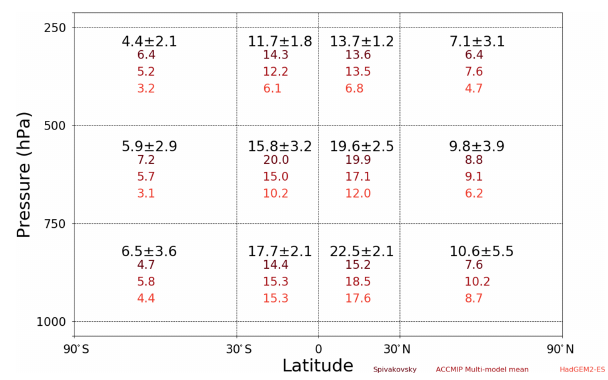
Figure 10. Evaluation of the UKCA StratTrop zonal distribution of tropospheric [OH] ( × 10 5 moleculescm − 3 ) in the FR simulation. Values plotted in black refer to the UKCA StratTrop multi-annual mean [OH] in each region of latitude and pressure range, with the values following being ± 1 standard deviation around the mean.